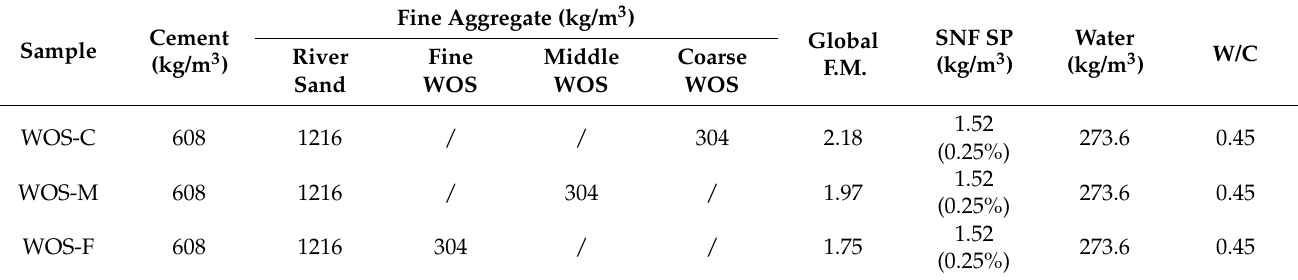
Table 2. Recipe for the test